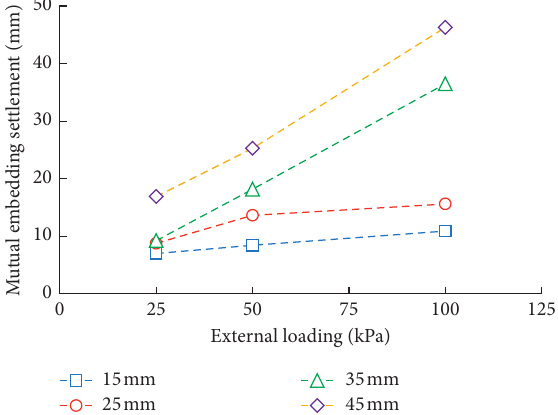
Figure 9: Effects ofexternal loadingson mutualembedding